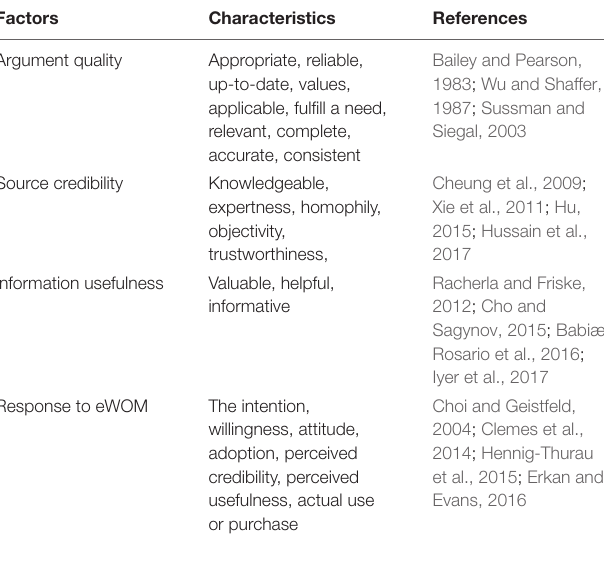
TABLE 1 | eWOM organizational vs. consumers’